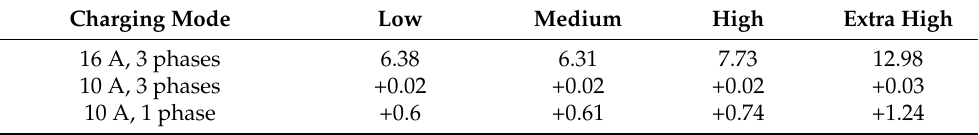
Table 11. Absolute and additional CO 2 -emissions in t/100,000 km sectioned in dependence of different charging modes for the Kia e-Niro referred to the optimal mode with 16 A and 3